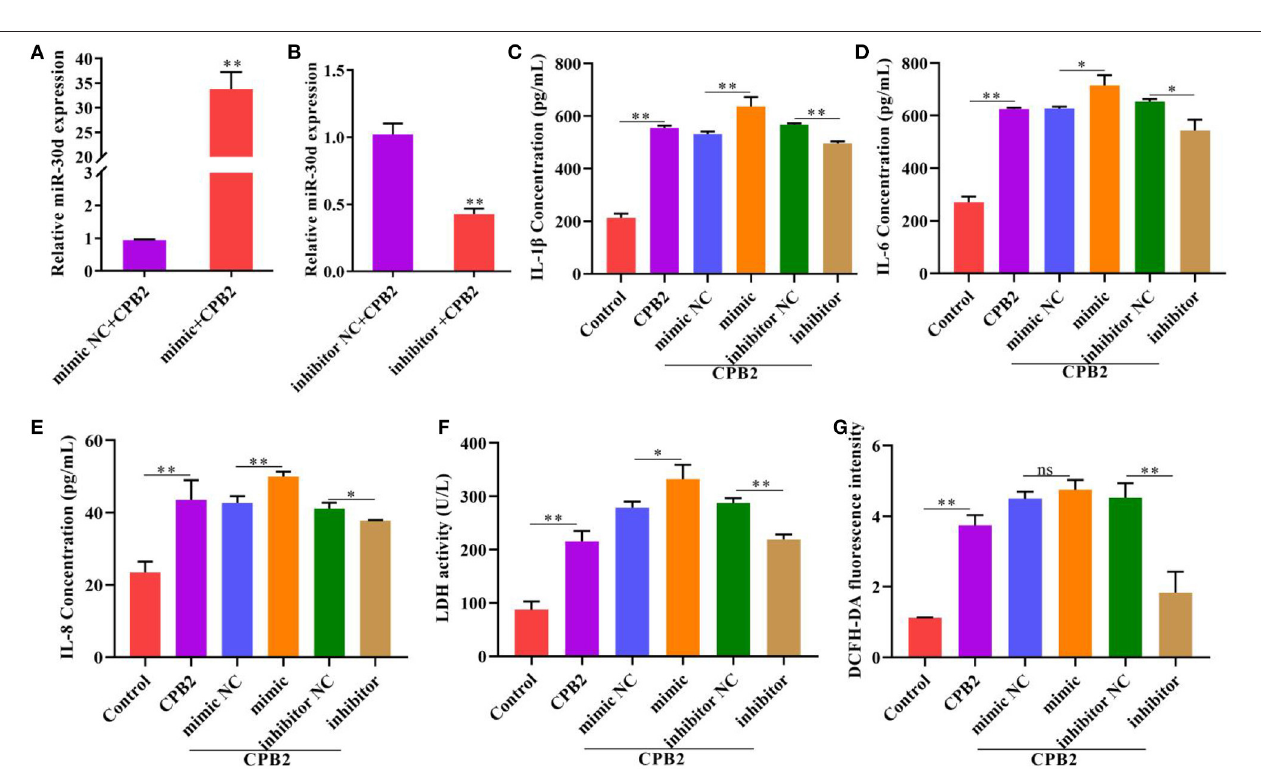
FIGURE 1 | miR-30d expression reduced in Clostridium perfringens type C-infected piglets and CPB2 toxin revulsive IPEC-J2 cells. (A) The expression of miR-30d in the ileum tissue of Clostridium perfringens type C-infected diarrhea piglets was evaluated via qPCR. (B) qPCR analysis of the expression of miR-30d in IPEC-J2 cells treated with CPB2 toxin at 12, 24, 36, and 48h. ** p < 0.01.